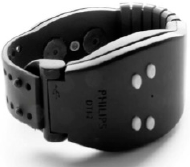
Figure 1. Philips DTI-2 wristband sensor.